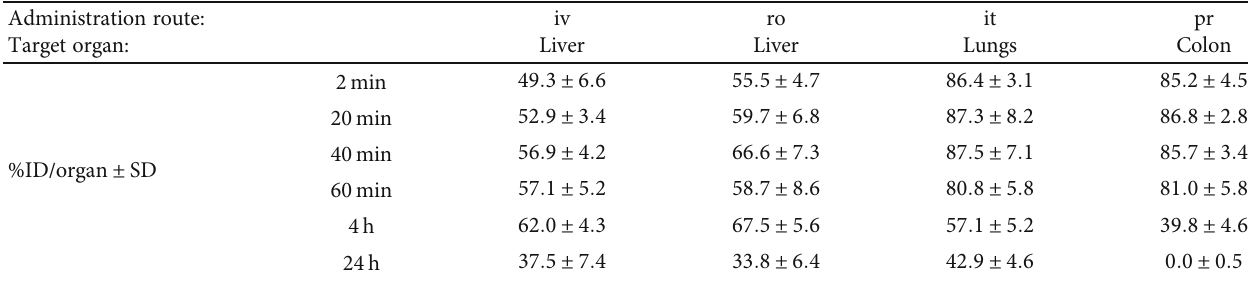
Table 3: % ID per organ calculated through visual|eyes ™ , for the target organs of each administration route, based on the images presented on Figure 7. Average values ± SDs are presented, based on minimum 2 animals per time point.